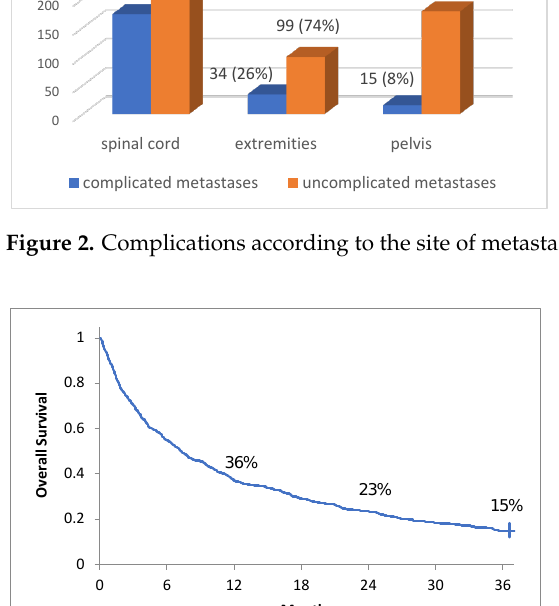
Figure 3. 1- 2- and 3-year OS of the study group.